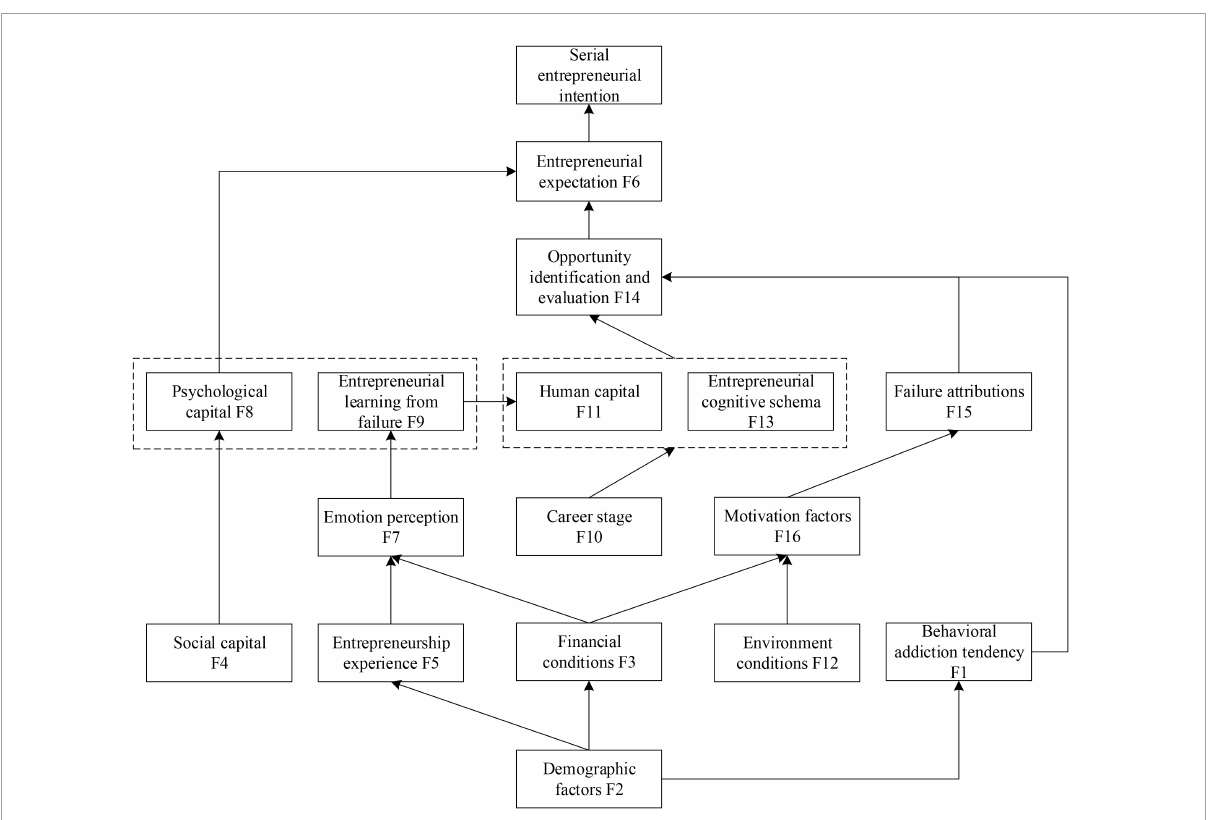
FIGURE1 Interpretive structure